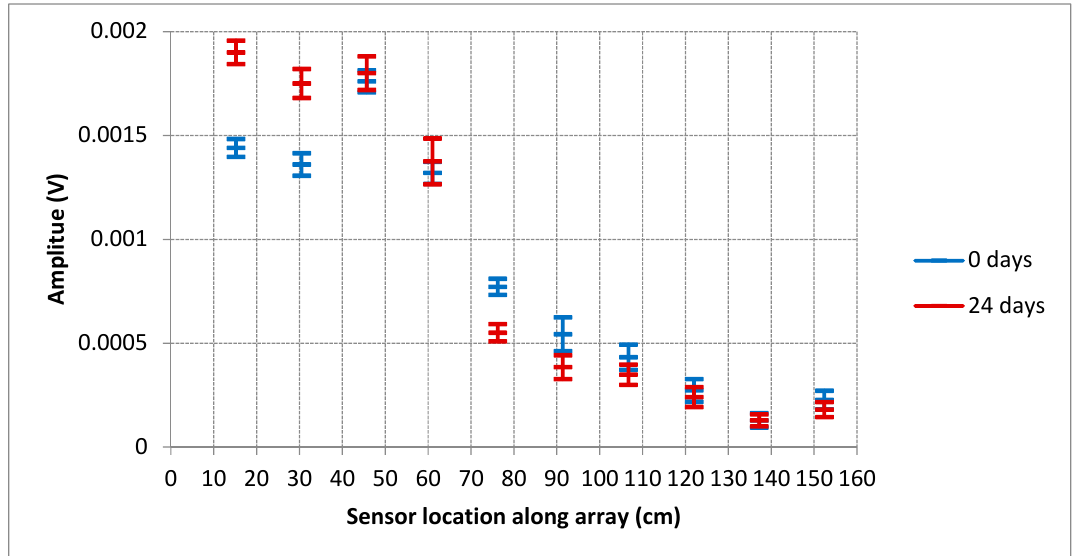
Figure 11. Results for corrosive conditions at the beginning of the rebar (Rebar 2) and the measurement array at the concrete edge, 61 cm (2 feet) away from the bar horizontally.